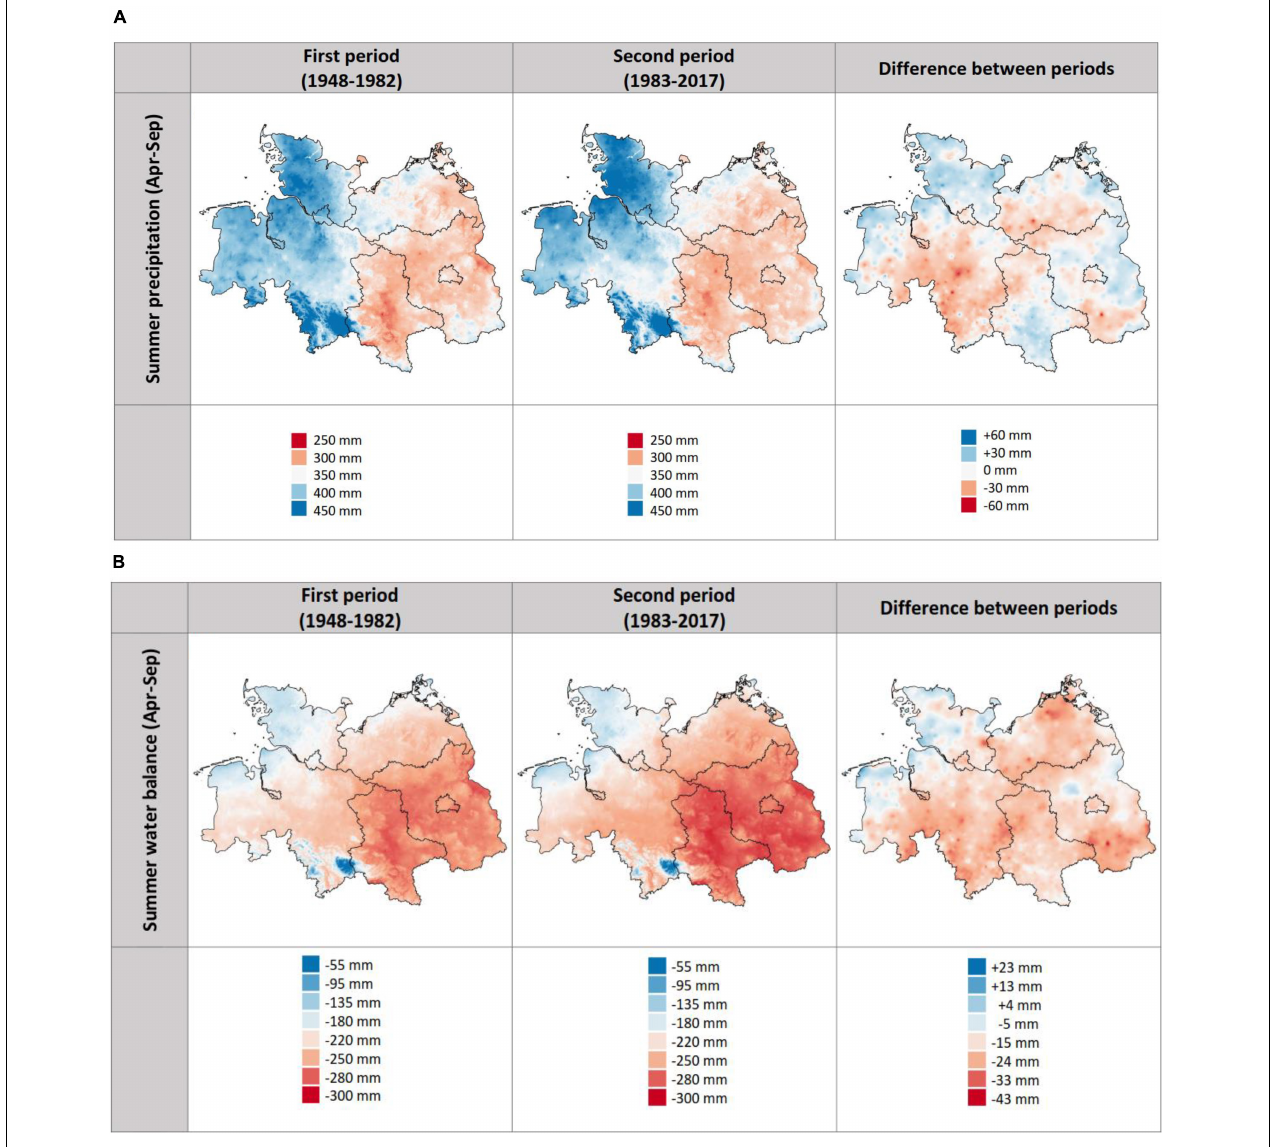
FIGURE 4 | Interpolation (DWD 1 km 2 -gridded climate data) of growing season precipitation (sum of April-September) (A) and growing season climatic water balance (CWB) (cumulated over April-September) (B) in the North German Lowlands: means of the periods 1948–1982 (left) and 1983–2017 (center), and differences between the two period means (right). Positive precipitation differences: increase, negative differences: decrease; positive CWB differences: reduced deficit, negative CWB differences: increased